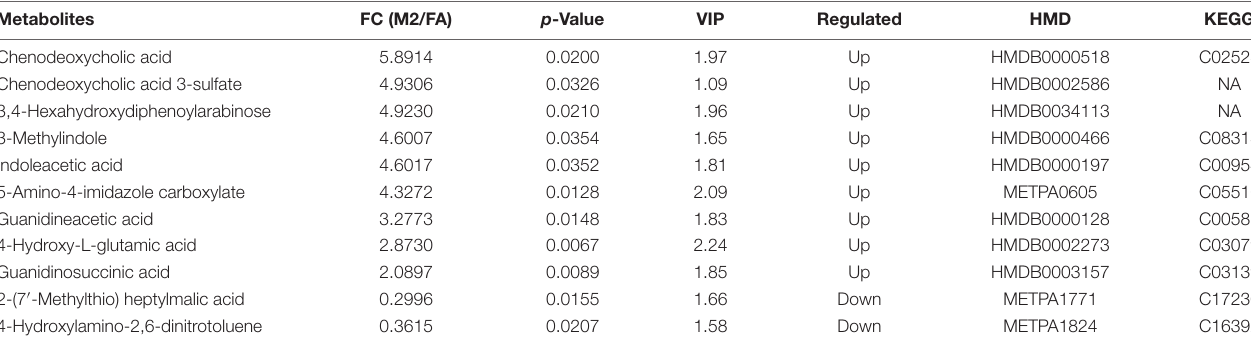
TABLE 2 | Significantly different metabolites in feces between FA and M2 groups. Metabolites